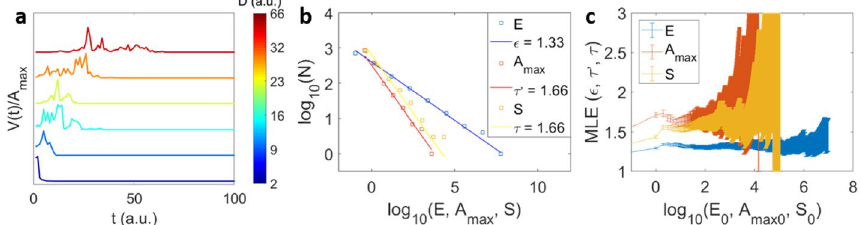
Figure 4. Avalanches of the collapse model. ( a ) Examples of normalized avalanche profiles V ( t ) /A max with different durations (blue to red means increasing the duration) for simulations of the model of Eq. (13). PDF ( b ) and maximum likelihood exponent (MLE) ( c ) of the energy ( E ), maximum amplitude A max and size S for the model of Eq. (13).